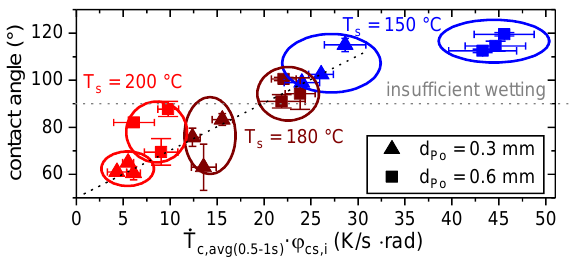
. T c , avg ( 0.5 − 1 s ) , and the preset contact